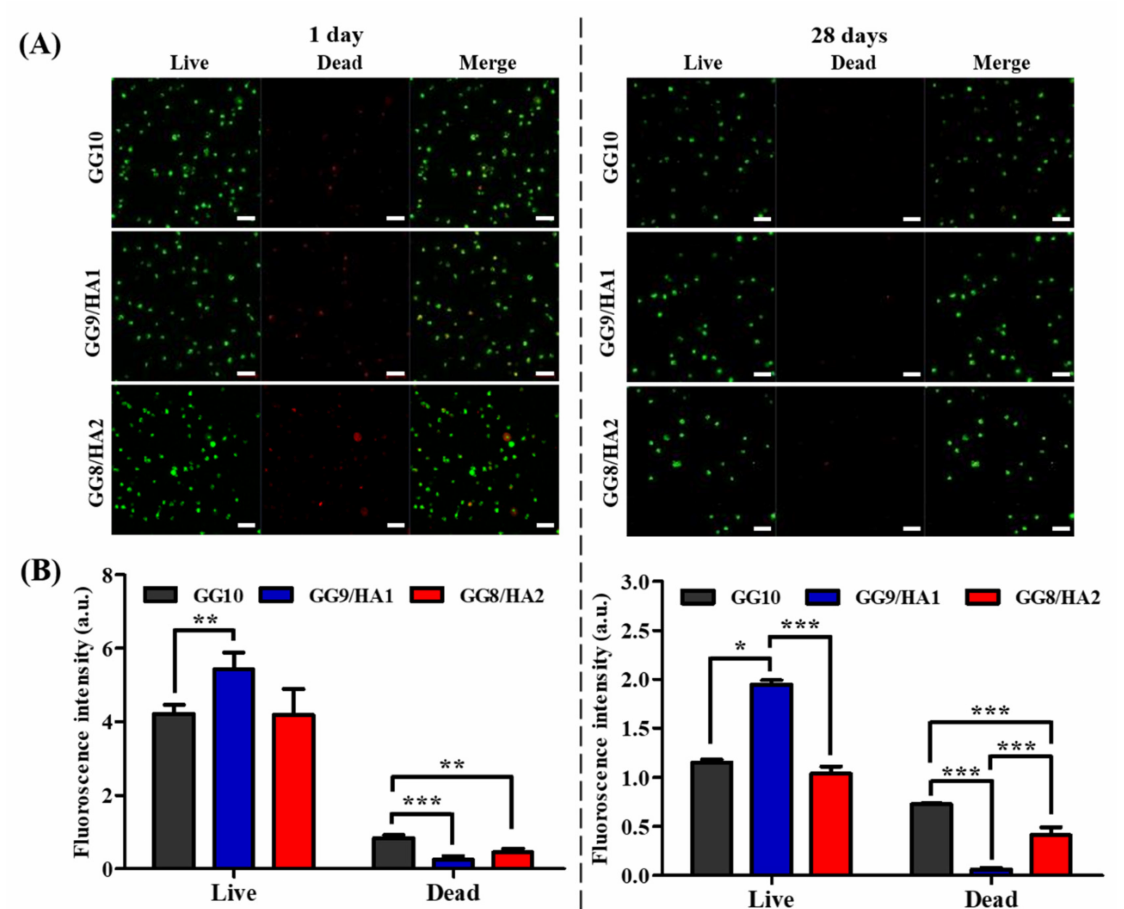
Figure 5. Biocompatibility characterization of the hydrogels: ( A ) live/dead staining images of ARPE-19-encapsulated hydrogels analyzed with the Z-stack mode; ( B ) relative intensity of live/dead images evaluated with ImageJ software (scale bar = 50 µ m) (values are mean ± SD, n = 4, p < 0.05 (*), p < 0.01 (**), p < 0.001